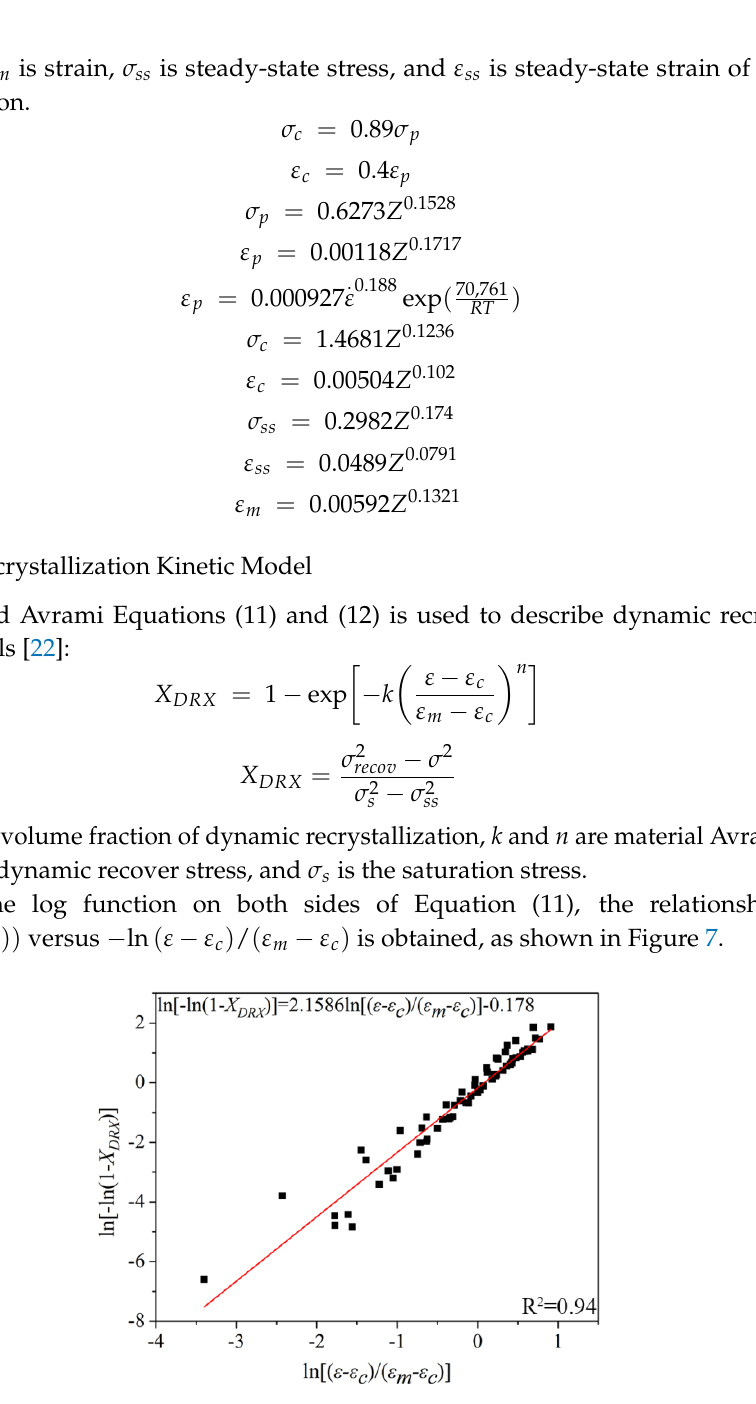
[ − ln ( 1 − X )] versus ln ( ε − ε c ) at different deformation ) at different deformation conditions. Figure 7. Schematic of ln DRX ε m − ε c ε m - ε c